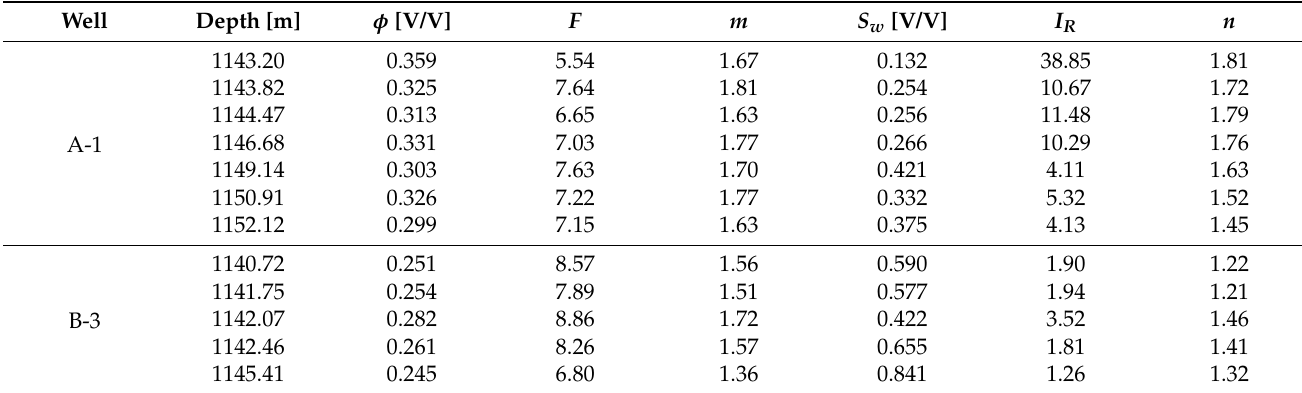
Table 3. Results of special core measurements performed at quasi-reservoir confining pressure for A-1 and B-3 wells— “Sand”